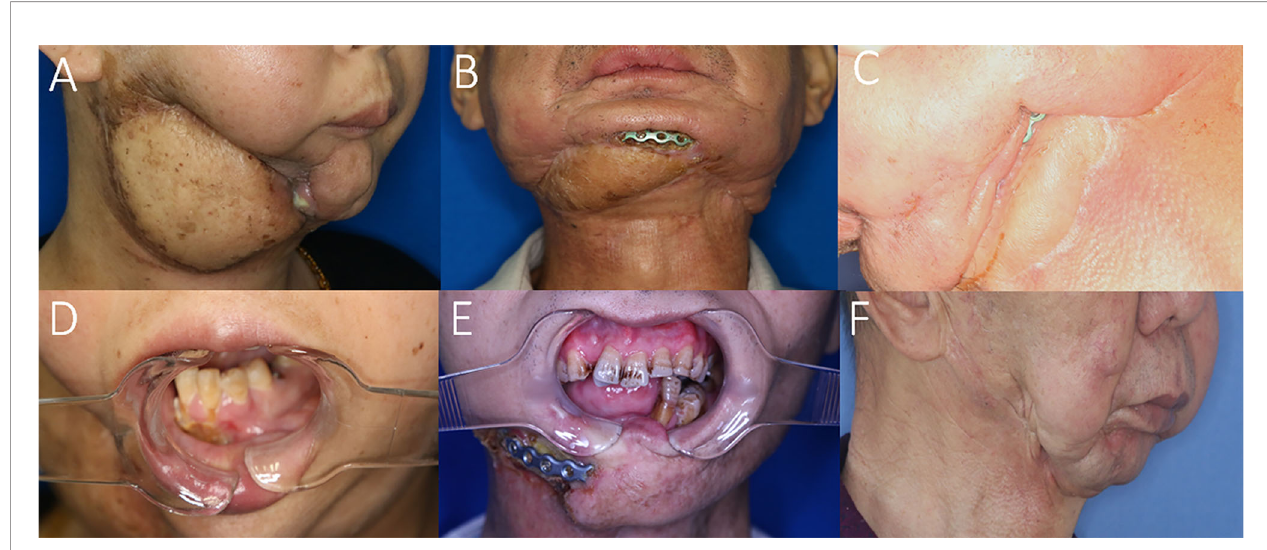
FIGURE 4 | Representative cases with recurrences and complications possibly due to STI mismanagement. (A) Insuf fi cient scar release and soft tissue debridement causing anterior bone exposure and oro-cutaneous fi stula 2 months after ORN treatment. (B) Insuf fi cient soft-tissue component for tissue coverage in the anterior mandibular region after ORN and STI debridement implying inconsiderate reconstructive design. (C) Insuf fi cient soft-tissue coverage causing plate exposure in the mandibular angle region. (D) The same patient of A with postoperative unrelieved trismus despite ORN mandibulectomy. (E) Postoperative trismus and recurrence of ORN due to both insuf fi cient bone and soft-tissue management. (F) Undesirable facial contour change and midline misalignment in the left-sided concaved lower face, due to erroneous scar release and insuf fi cient soft tissue fl ap